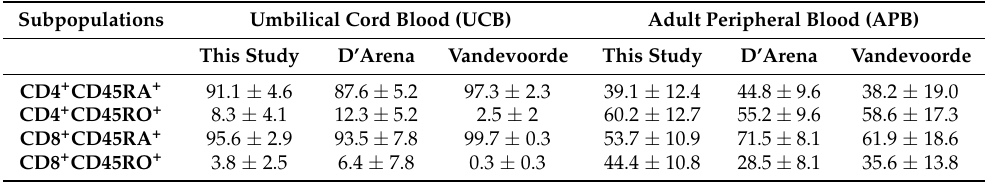
Table 3. The percentage of naïve and memory CD4 + and CD8 + T-lymphocytes determined in UCB and APB in the study, compared to previous studies. Values are expressed as mean percentage ( ± SD). Subpopulations Umbilical Cord Blood (UCB) Adult Peripheral Blood (APB) This Study D’Arena Vandevoorde This Study D’Arena Vandevoorde CD4 + CD45RA + 91.1 ± 4.6 87.6 ±